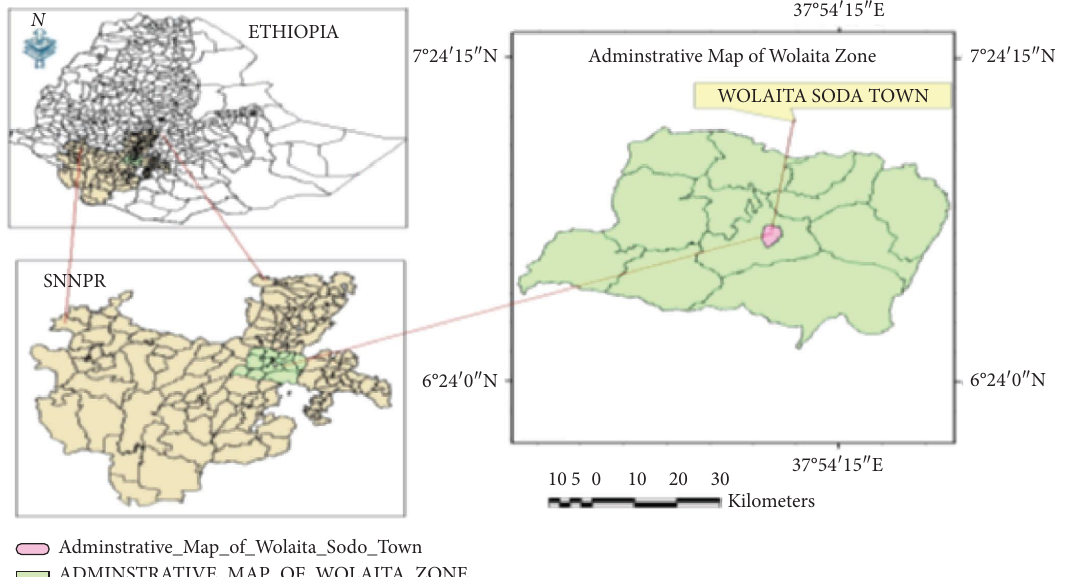
Figure 1: Map of the study